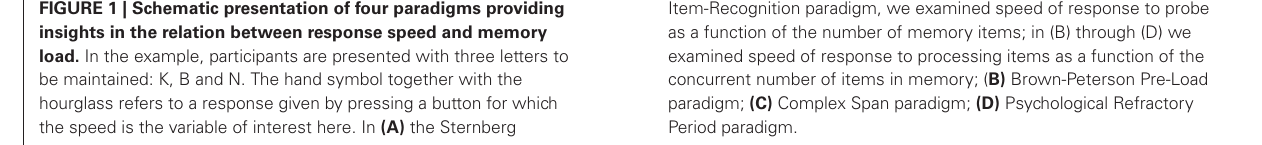
Item-Recognition paradigm, we examined speed of response to probe as a function of the number of memory items; in (B) through (D) we examined speed of response to processing items as a function of the concurrent number of items in memory; ( B) Brown-Peterson Pre-Load paradigm; (C) Complex Span paradigm; (D) Psychological Refractory Period